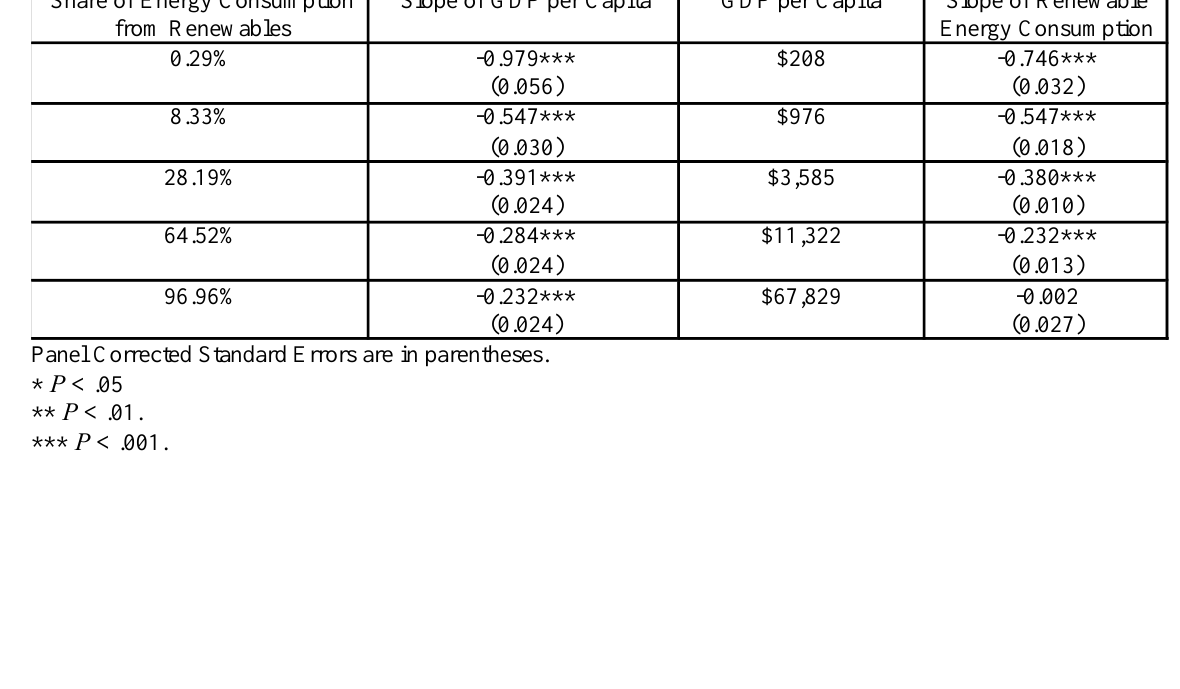
Table 6: Slope Coefficients of GDP per Capita and Renewable Energy Consumption S h a r e o f E n e r gy C on s u m p ti